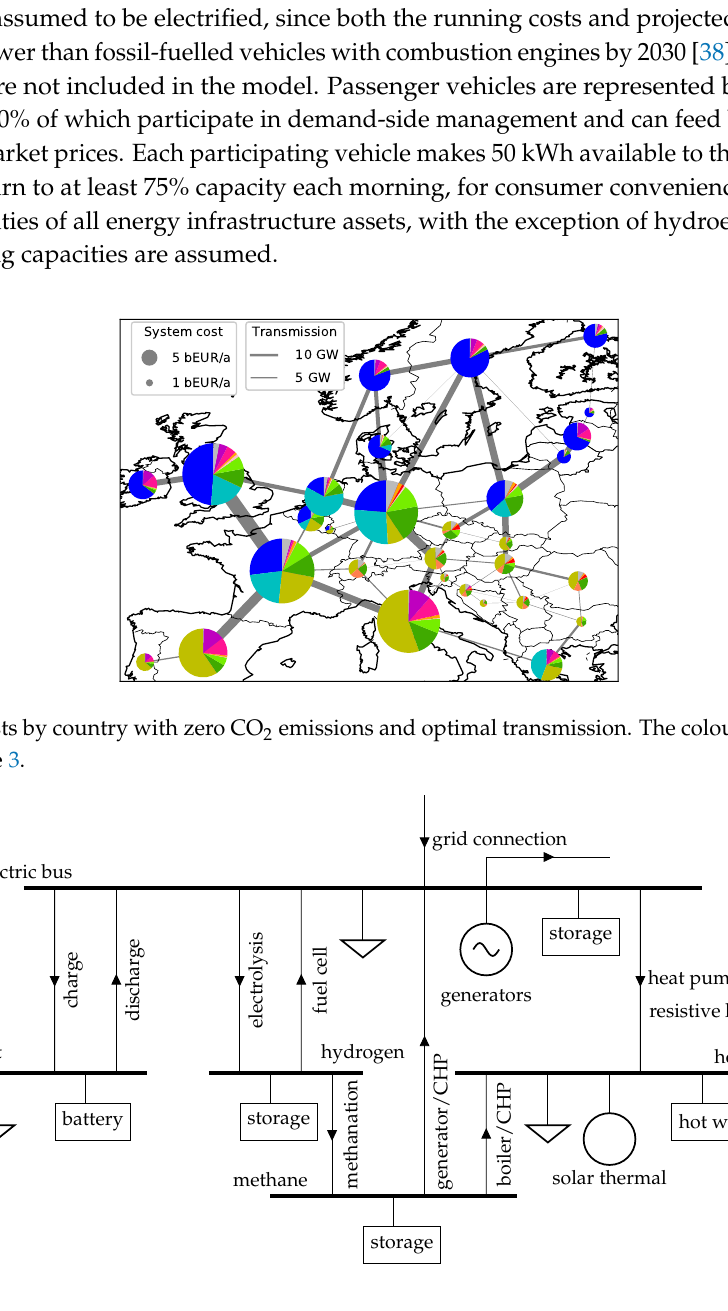
Figure 2. Energy flow at a single node. In this model, a node represents a whole European country. Within each node, there is a bus (thick horizontal line) for each energy carrier (electric, transport, heat, hydrogen, and methane), to which different loads (triangles), energy sources (circles), storage units (rectangles), and converters (lines connecting buses) are attached. The lines with arrows show the direction of energy transfer (Source: